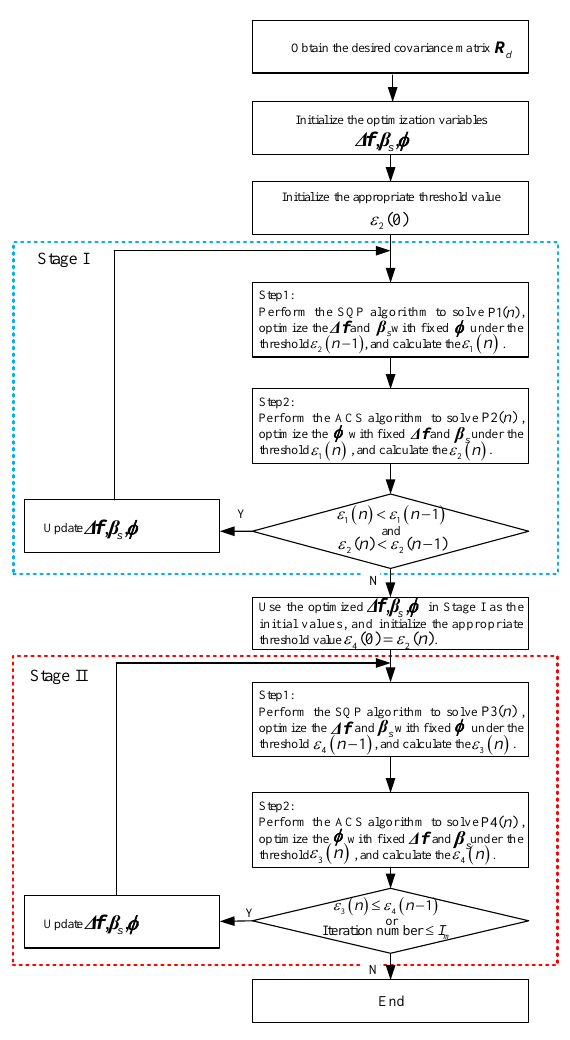
Figure 9. The flowchart of proposed optimization